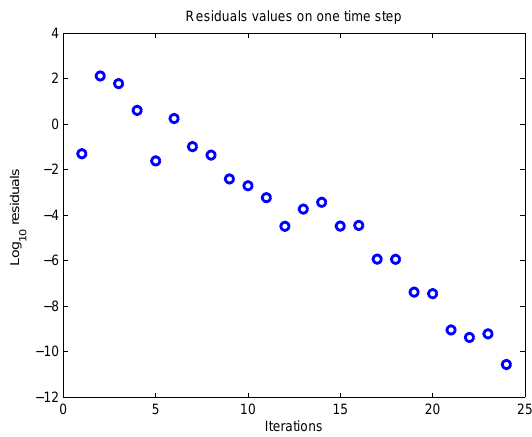
Fig. 2. Sample residuals plotted for one time step.